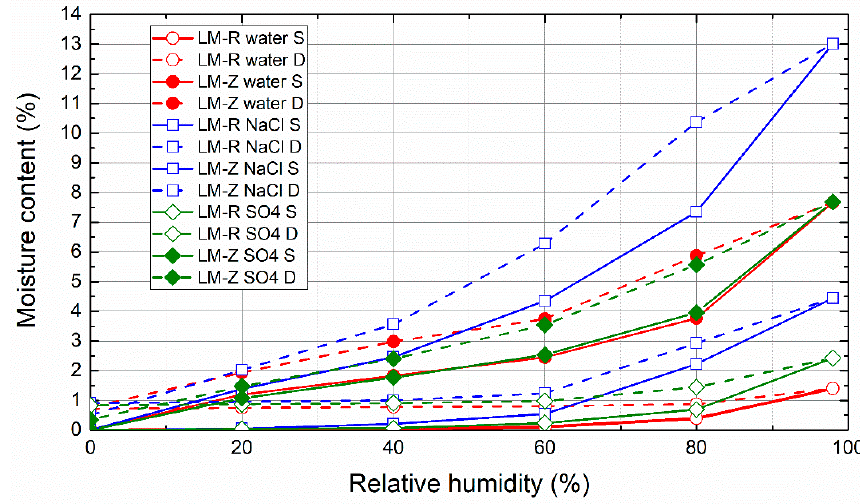
Figure 9. Sorption and desorption isotherms of lime mortars (LM).